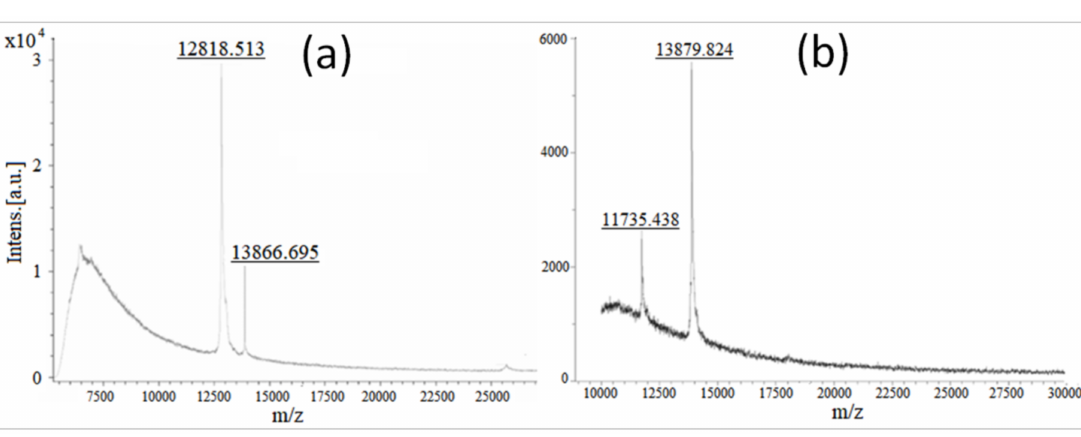
Figure 4. MALDI-TOF analysis of self-organized peptide biomaterials. ( a ) Spectra of m / z 12,818.513/13,866.695 peptides synthesized at 37 ◦ C. ( b ) Spectra of m / z 11,735.438/13,879.824 peptides synthesized at 50 ◦ C.